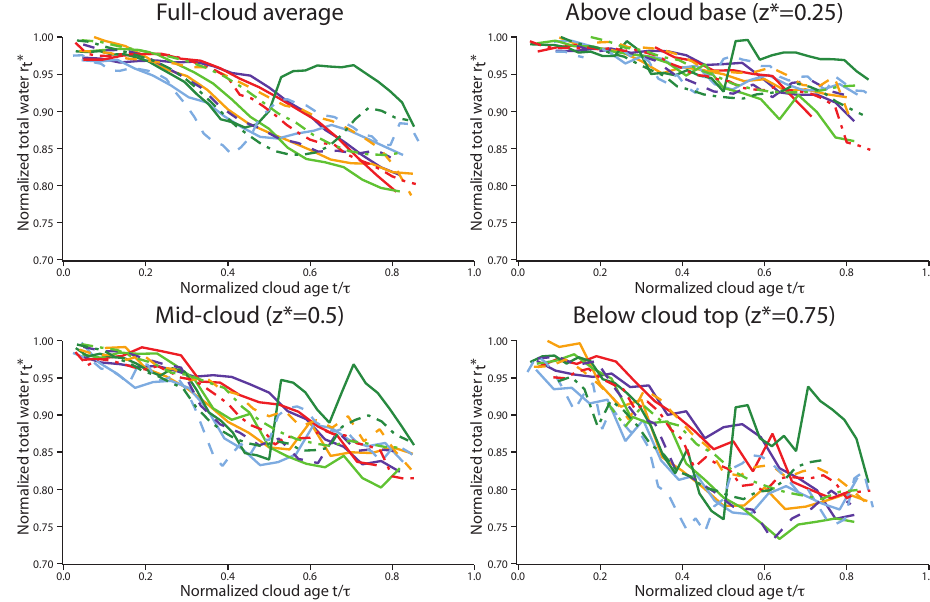
Figure 9. Individual altitude time series of r ∗ t show the same general trend as the full-cloud average, but higher altitudes exhibit a larger dynamic range.